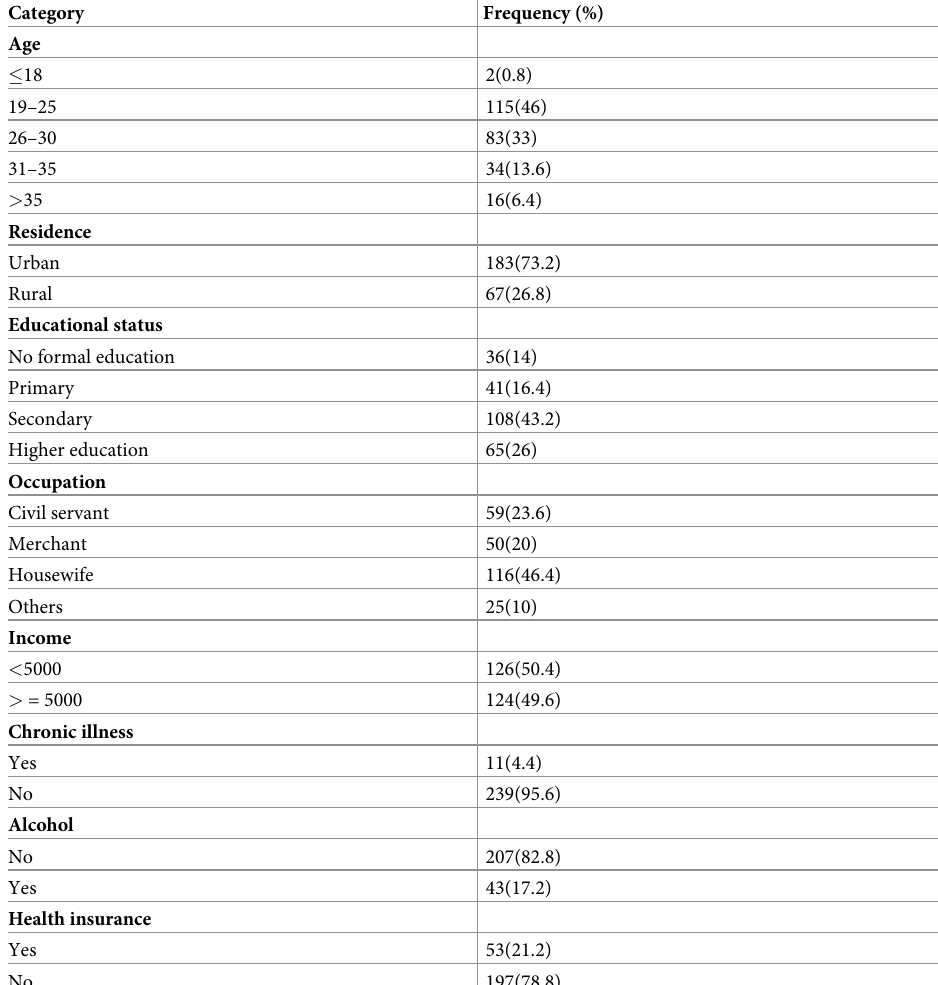
Table 1. Socio-demographic characteristics of participants (n =